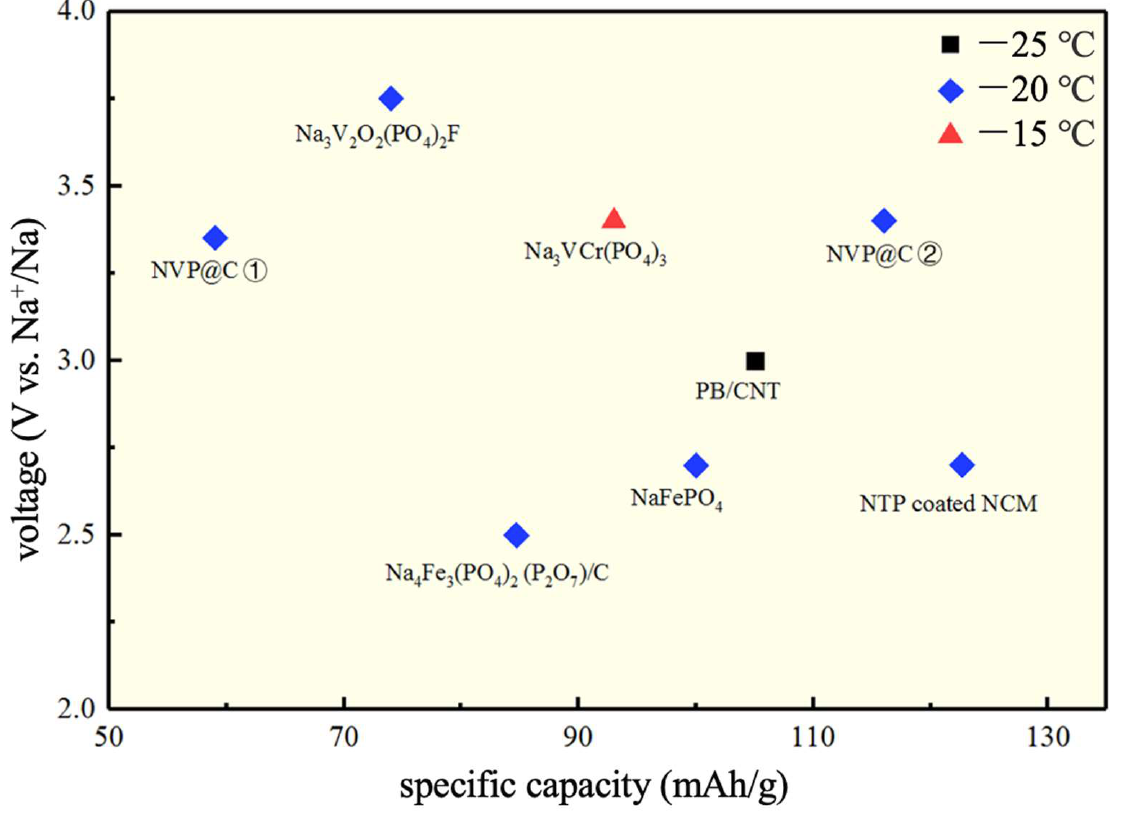
Figure 5. Eight different representative cathode materials in low temperatures which are carbon- coated Na 3 V 2 (PO 4 ) 3 and conventional organic electrolytes at a 1 C rate (NVP@C 1 (cid:13) in Figure 5) [33], hybridized Na 3 V 2 O 2 (PO 4 ) 2 F tested at a 1 C rate [40], Na 3 VCr(PO 4 ) 3 tested at 0.1 C [29], carbon-coated NaFePO 4 at 0.1 C [28], Na 2 Fe[Fe(CN) 6 ] and carbon nanotubes at a 0.1 C rate [18], carbon-coated Na 3 V 2 (PO 4 ) 3 and ionic liquid electrolytes (NVP@C 2 (cid:13) in Figure 5) at a 1 C rate [31], and NaTi 2 (PO 4 ) 3